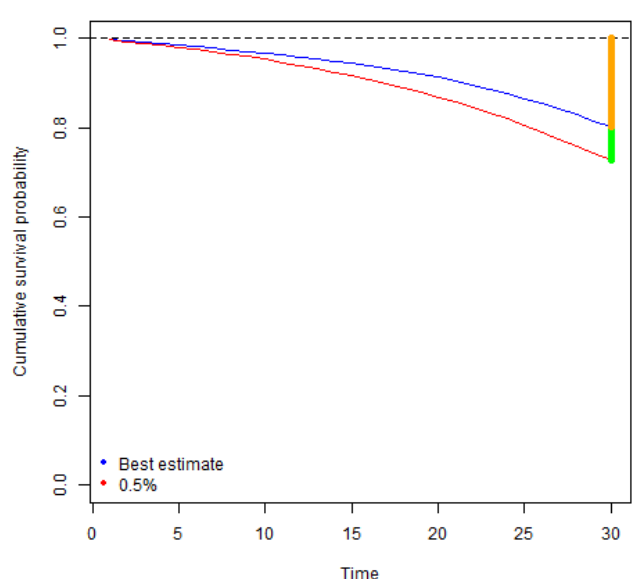
Figure 10. Calculation of the Best Estimate (orange line) and run-off VaR (green line) for term life assurance with level sum insured for the policy term of 30 years. The red line represents 0.5% confidence interval of the survival probability, which is equivalent to 99.5% confidence interval of the cumulative death